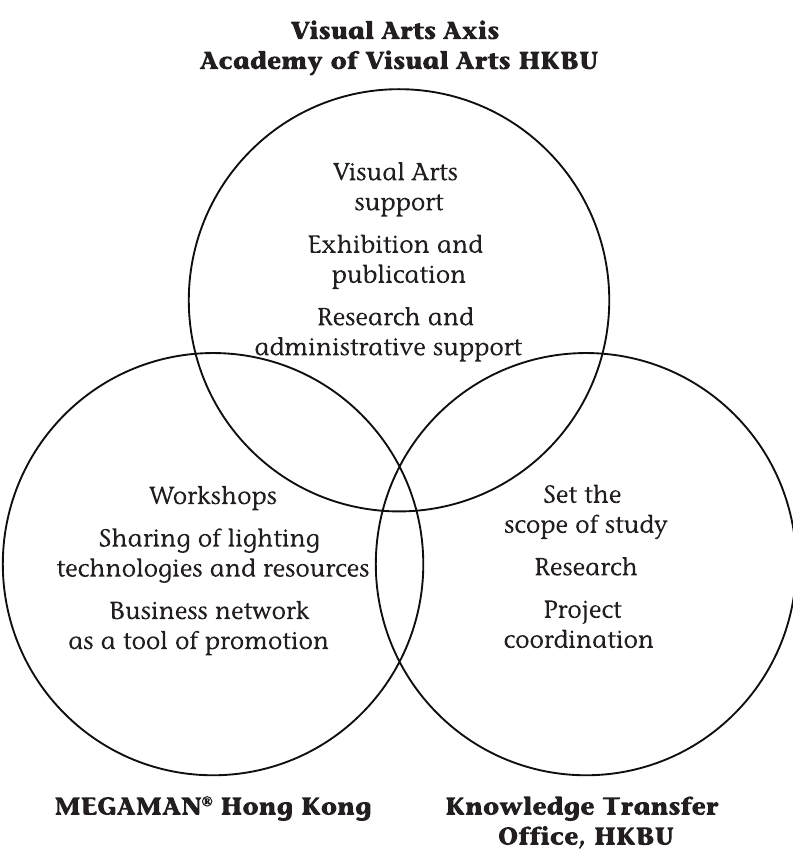
Figure 1: Overview of the three parties’